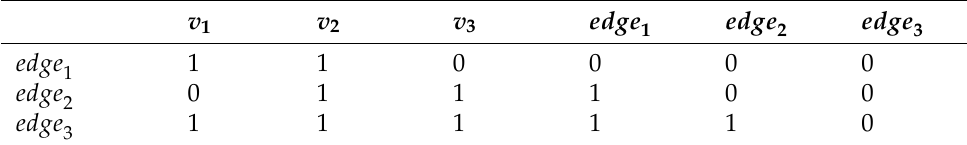
Table 3. Incidence matrix for the generalized hyper-graph example.